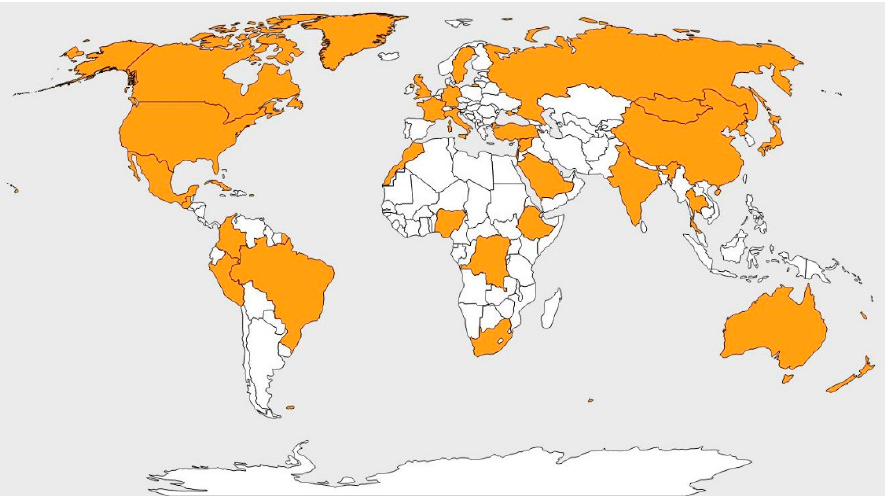
Figure 7. Selection of the countries or regions as test regions.